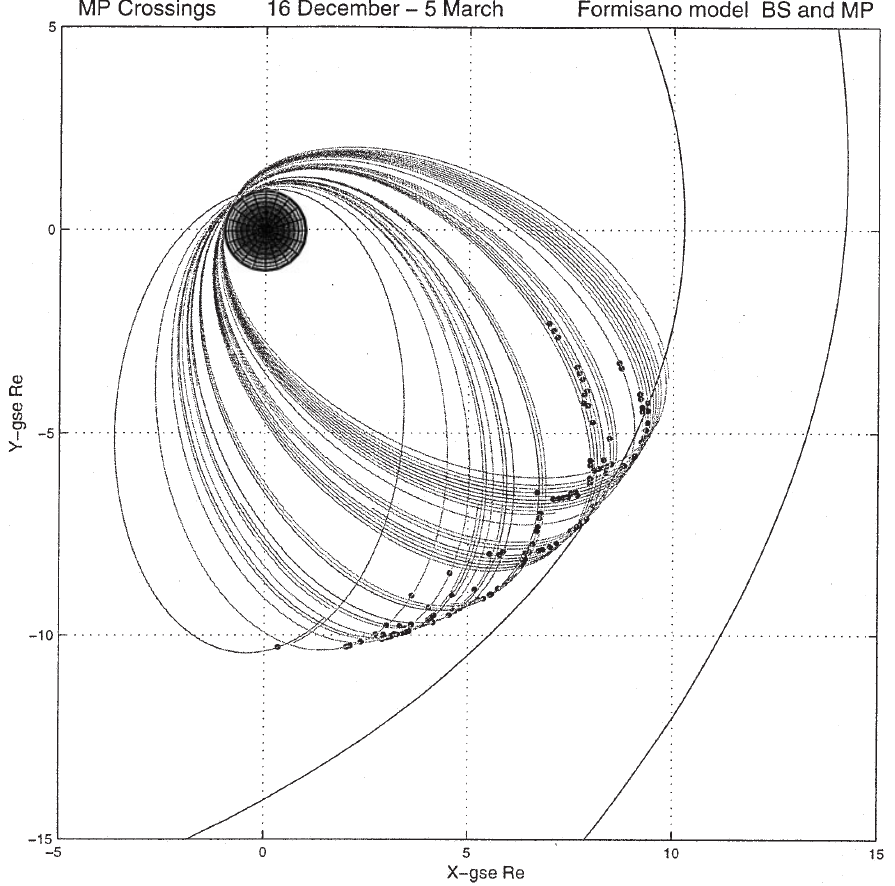
Fig. 1. Overview of the crossing locations. The Equator-S orbit for the 31 passes corresponding to the obser- vations is superimposed to indicate occurrence and cuts through a model bow shock and magnetopause for mean solar wind conditions are also shown (after Dunlop et al.